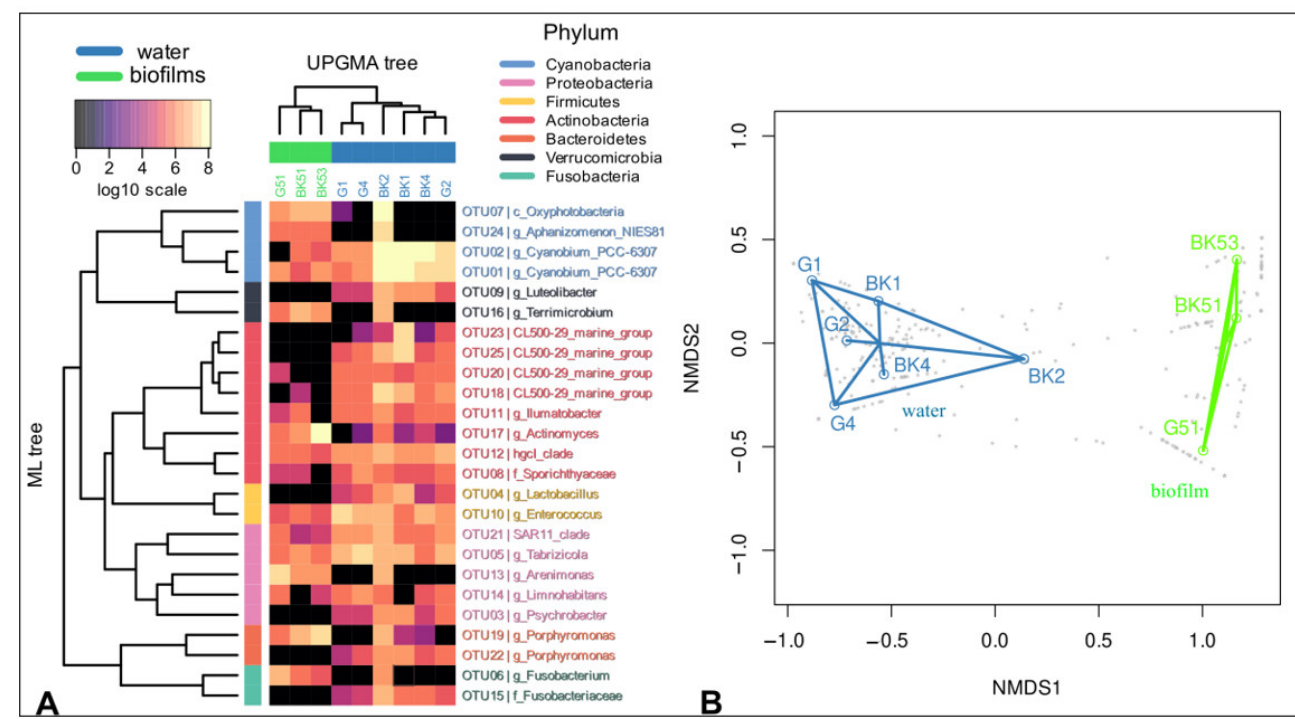
Figure 2. Similarities and differences between epilithon (G51, BK51, BK53), neuston (BK1, G1), and plankton (BK2, BK4, G2, G4) of Lake Baikal. Heatmap of 25 most represented OTUs 0.03 of 16S rRNA gene, UPGMA dendrogram and phylogenetic tree ( A ) and NMDS plot ( B ) based on the Bray-Curtis similarity matrix. Blue lines highlight water cluster of samples; green lines highlight epilithic biofilms cluster of samples. BK—samples taken off the Bol’shiye Koty settlement; G—samples taken off the Bol’shoye Goloustnoye settlement.